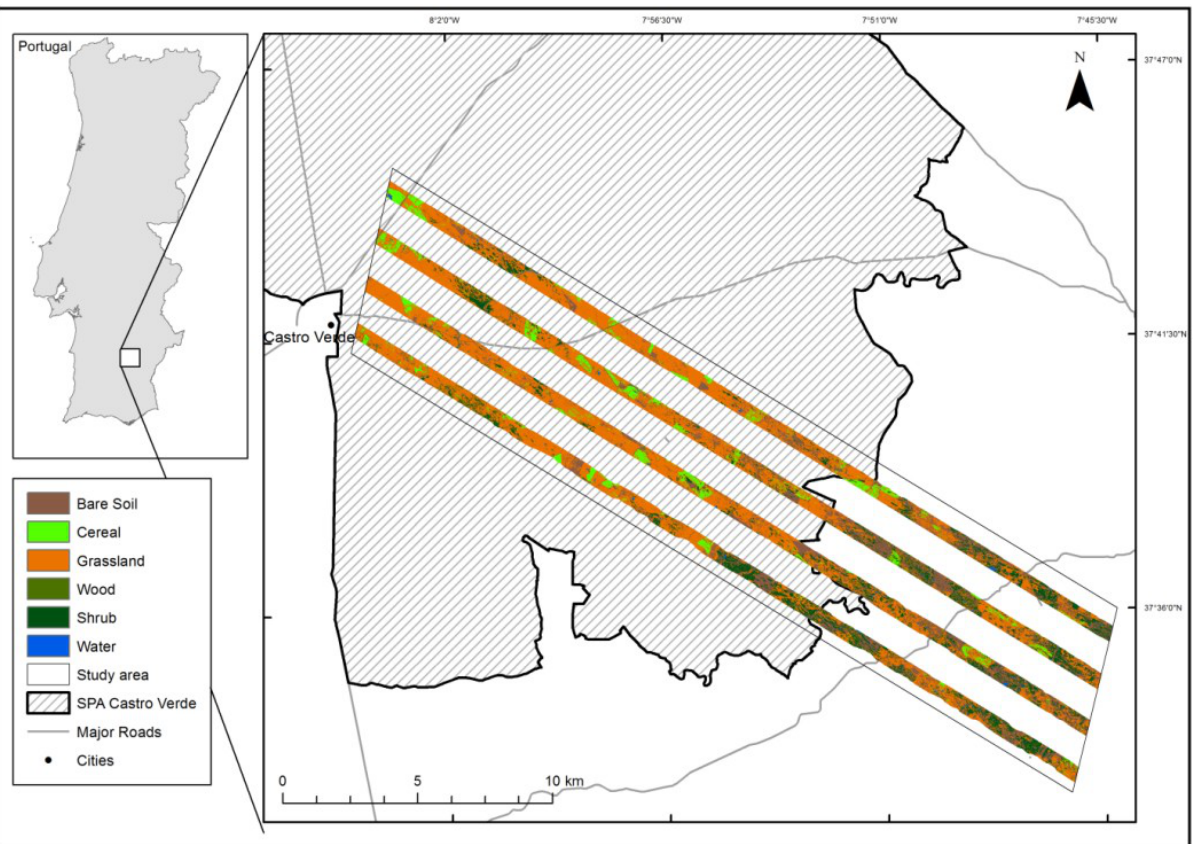
Figure 1. Study area in southern Portugal and classified land cover. The area covers partly the Special Protected Area Castro